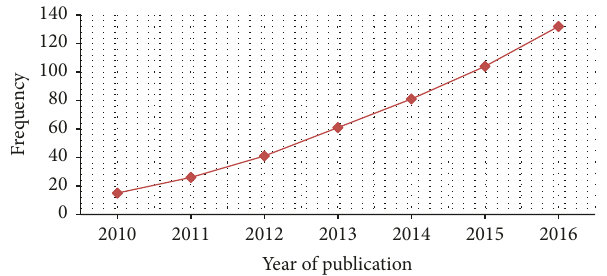
Figure 4: Distribution of articles by year of publication.